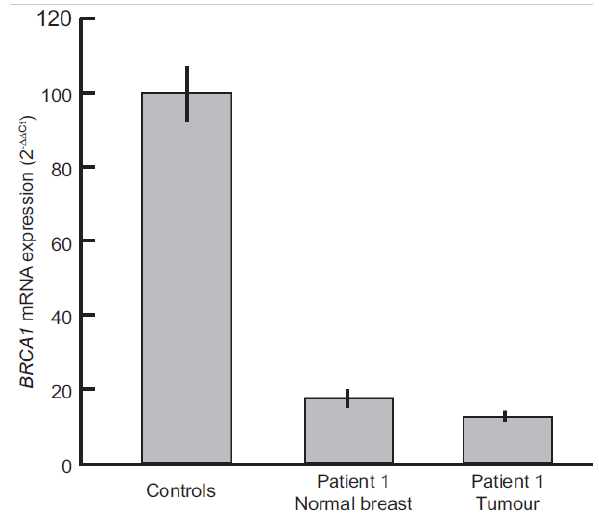
Figure 4. BRCA1 mRNA levels in Patient 1 tumor tissue and normal breast vs. breast tissue from healthy controls ( n = 2), as determined by real-time PCR. Bars represent mean expression values and vertical lines indicate the standard deviation between at least two independent experiments.